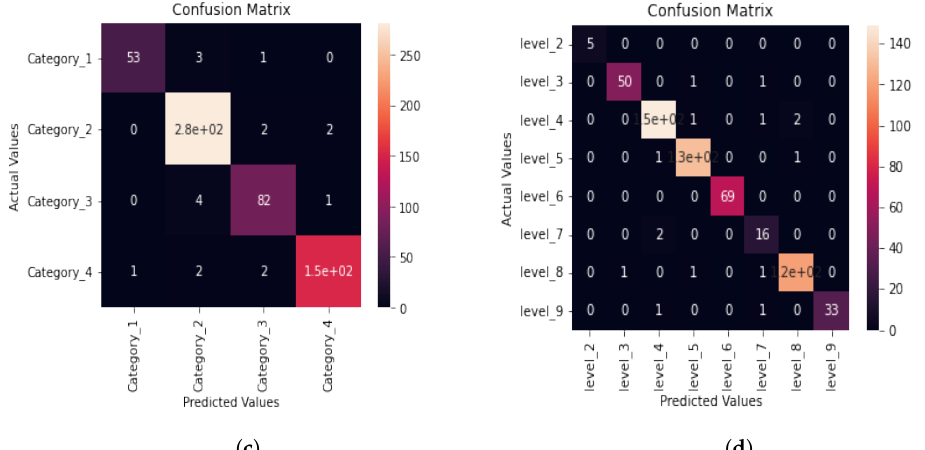
Figure 8. Confusion matrices of DNN machine learning model for different aphasia classifications whose features are extracted using MFCC for audio chunks of different lengths. ( a ) Confusion matrix of DNN for aphasia category classification using 20 s audio chunks. ( b ) Confusion matrix of DNN for aphasia severity level classification using 20 s audio chunks. ( c ) Confusion matrix of DNN for aphasia category classification when 10 s audio chunks are provided as input. ( d ) Confusion matrix of DNN for aphasia severity level classification when 10 s audio chunks are provided as input.